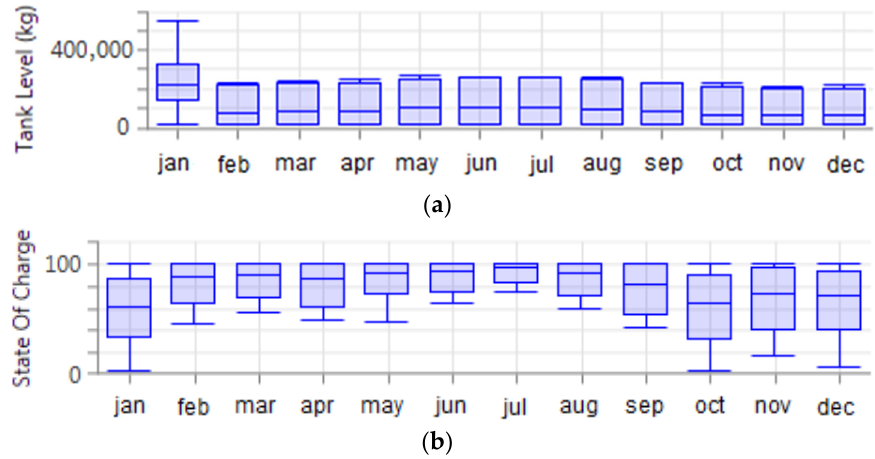
Figure 17. Monthly data of the storage systems. ( a ) Reverse pumping; ( b ) mega-batteries. Additionally, as shown in the hourly representation of typical summer and winter days (Figure 18), these periods are the least and most adverse situations for the system, respectively. As for the previous case, since the greatest generation contribution comes from solar PV, then the lower radiation and sun hours are in winter months, so this is the worst scenario. In both cases, two storage system are needed, but in the typical winter day (Figure 18b) the pumping subsystem of the reverse storage is only able to cover the first night hours, after which the discharge of the mega-batteries provides the demanded en- ergy. When electrical surpluses begin, both subsystems start their replenishment. How- ever, the upper dams of the pumping system cannot be completely refilled (indeed, their capacity is less than 50%), because at maximum pumping power they need about 16 h for to refill completely, and in the winter months the hours with excess production in the system barely reach 7 or 8. In the summer months (Figure 18a) the situation is similar but with a greater refilling of the two systems, although in the case of pumping limited by the high refilling time (Figure 17a), while the batteries are close to their maximum charge (Figure 17b). Therefore, in spite of the abovementioned issues, the pumping system is able to provide the necessary energy until later in the night, so that the battery input is delayed, with the consequent lower discharge of the batteries.